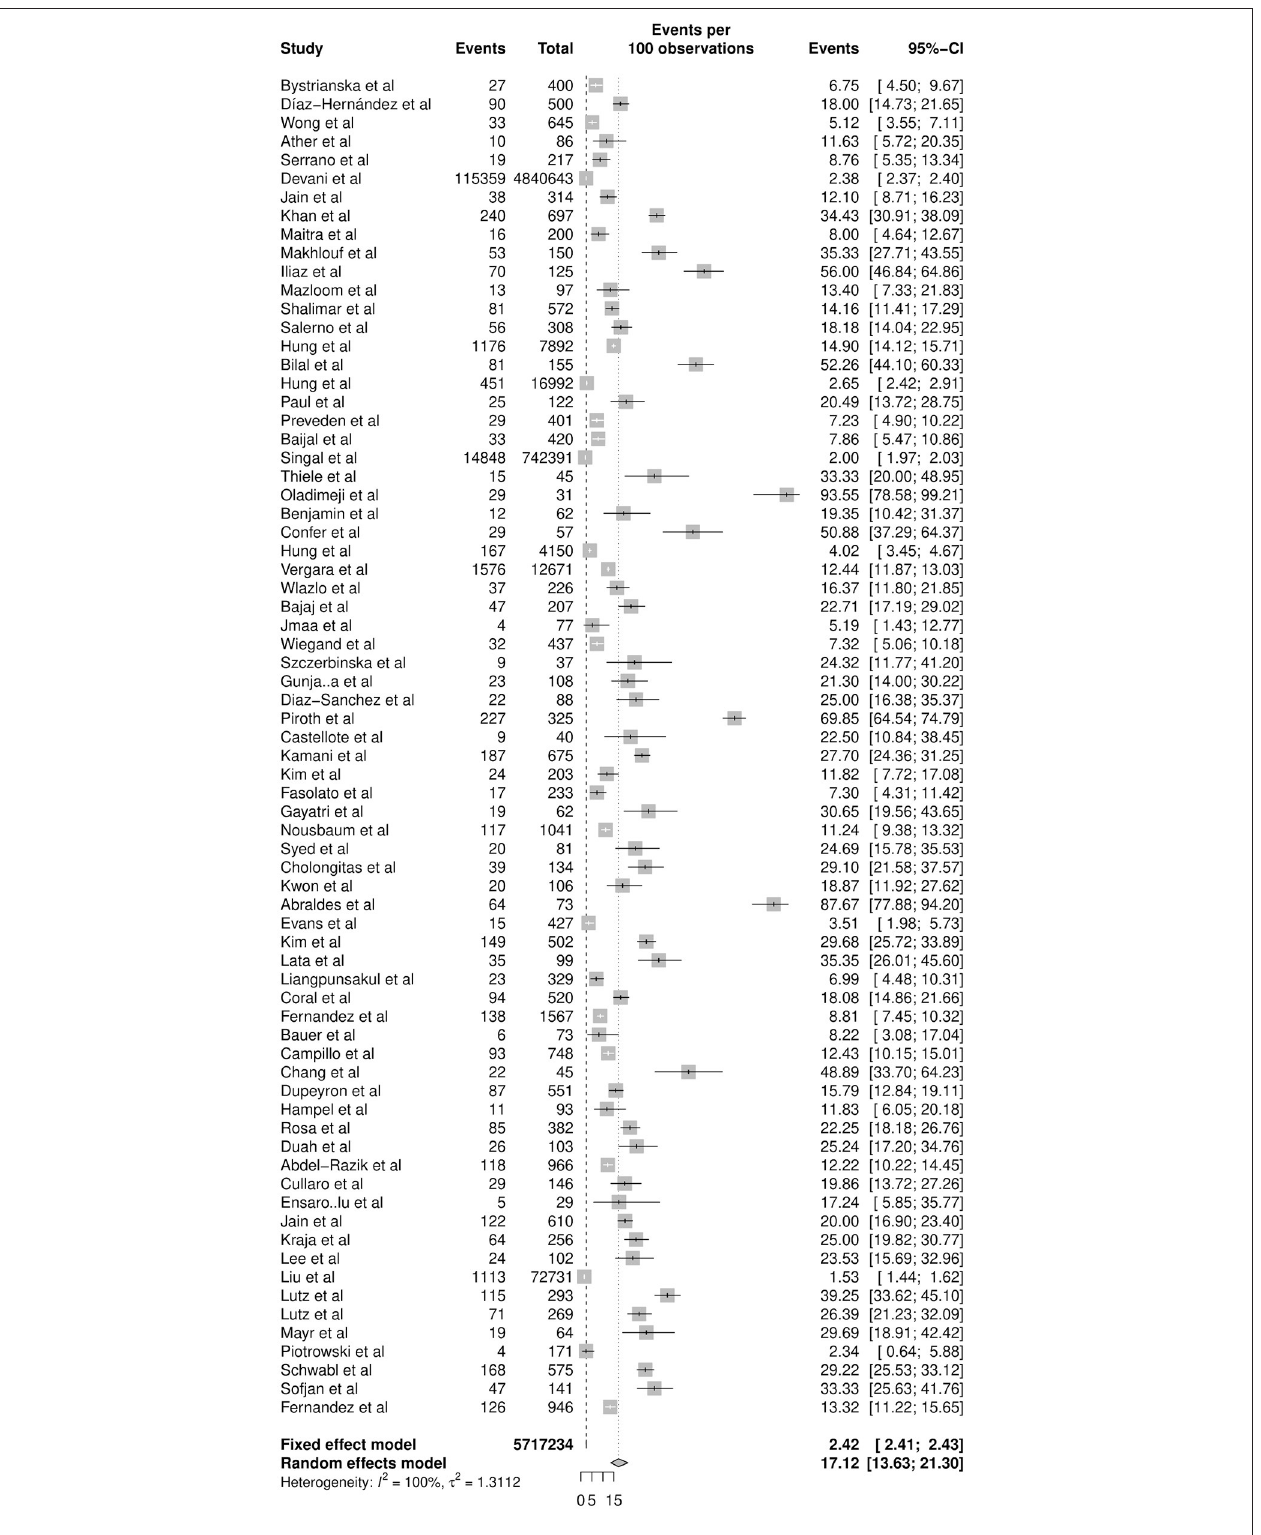
Frontiers in Medicine |